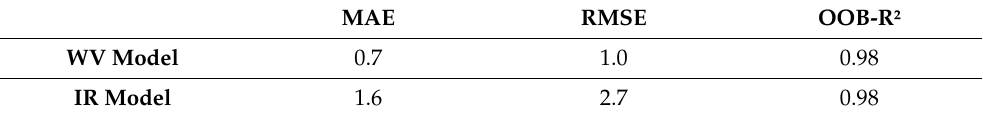
Table 3. Performance metrics of RF models (WV and IR